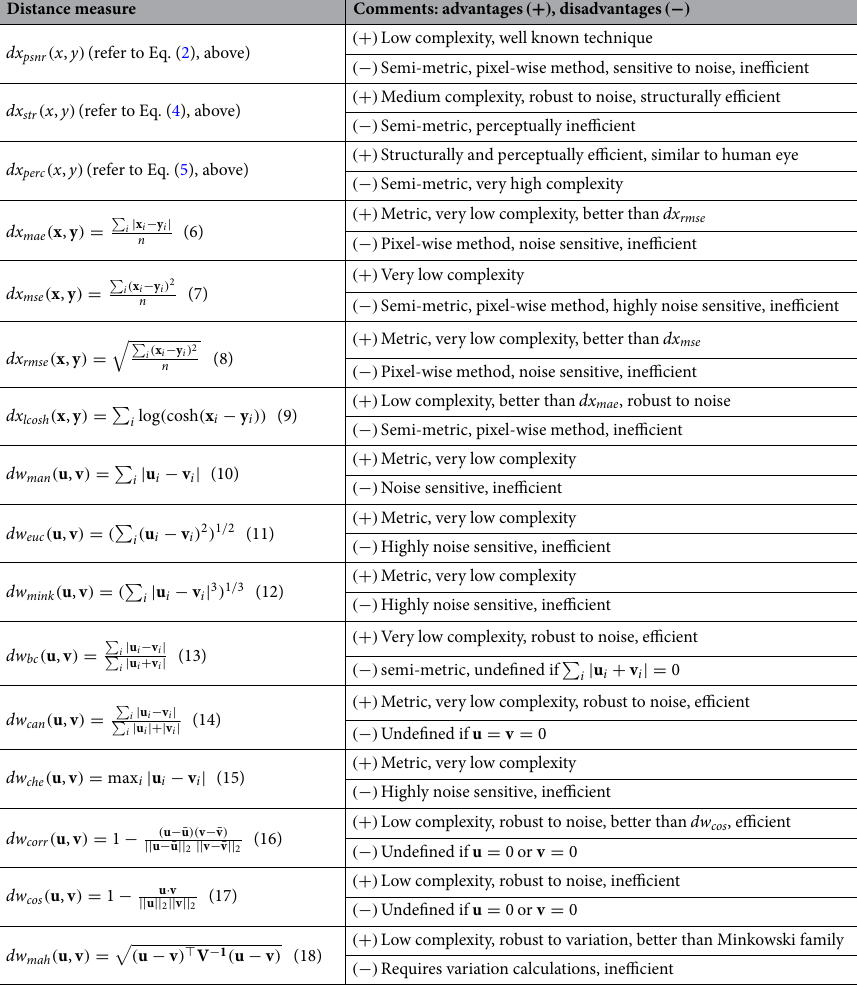
Table 1. Distance measures employed (left-hand column, with equation numbers) and their key characteristics including metric/semi-metric, algorithmic complexity, noise sensitivity, and efficiency on anomaly detection (right-hand column). Note that while images are represented with variables x and y , latents are expressed via u and v . Similarly, dx and dw represent distances in image space X and latent space W ,